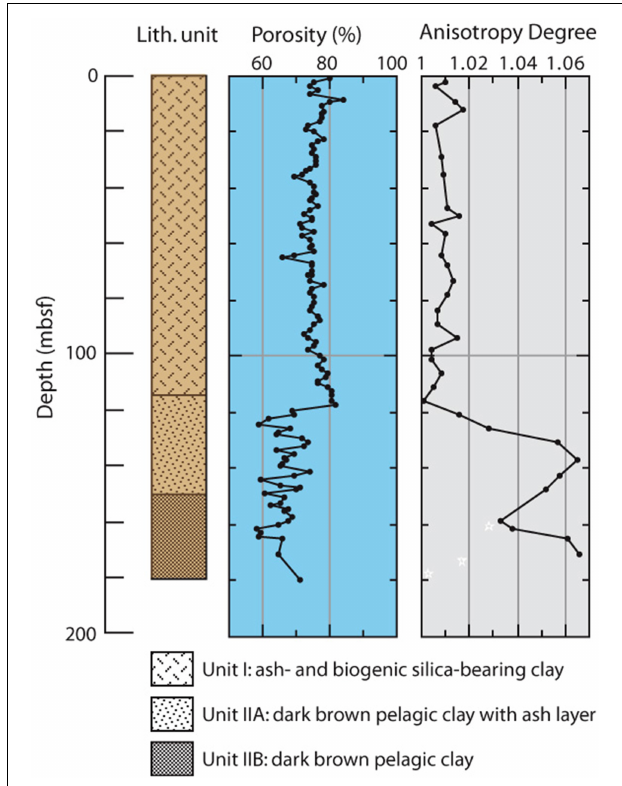
FIGURE 4 | Changes of porosity and anisotropy degree (P) with depth (IODP Hole 1149A) (modified from Kawamura and Ogawa,